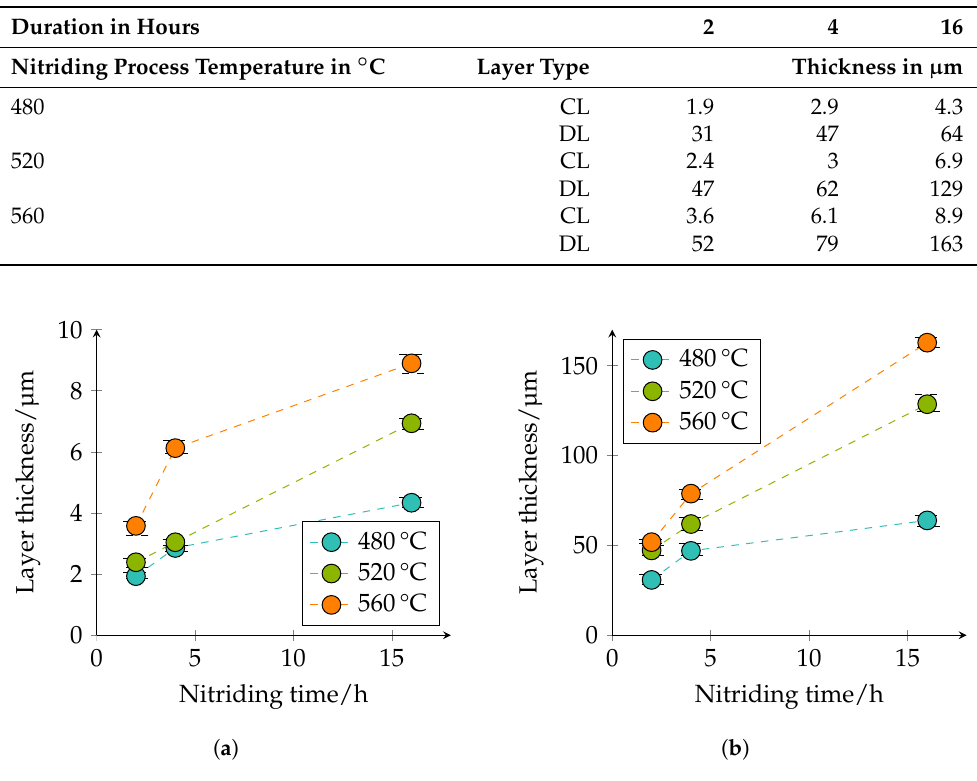
Figure 9. Thickness of compound and diffusion layers depending on the temperature and duration of plasma nitriding measured in the optical microscopy images. ( a ) Thickness of the compound layer (CL). ( b ) Thickness of the diffusion layer (DL).